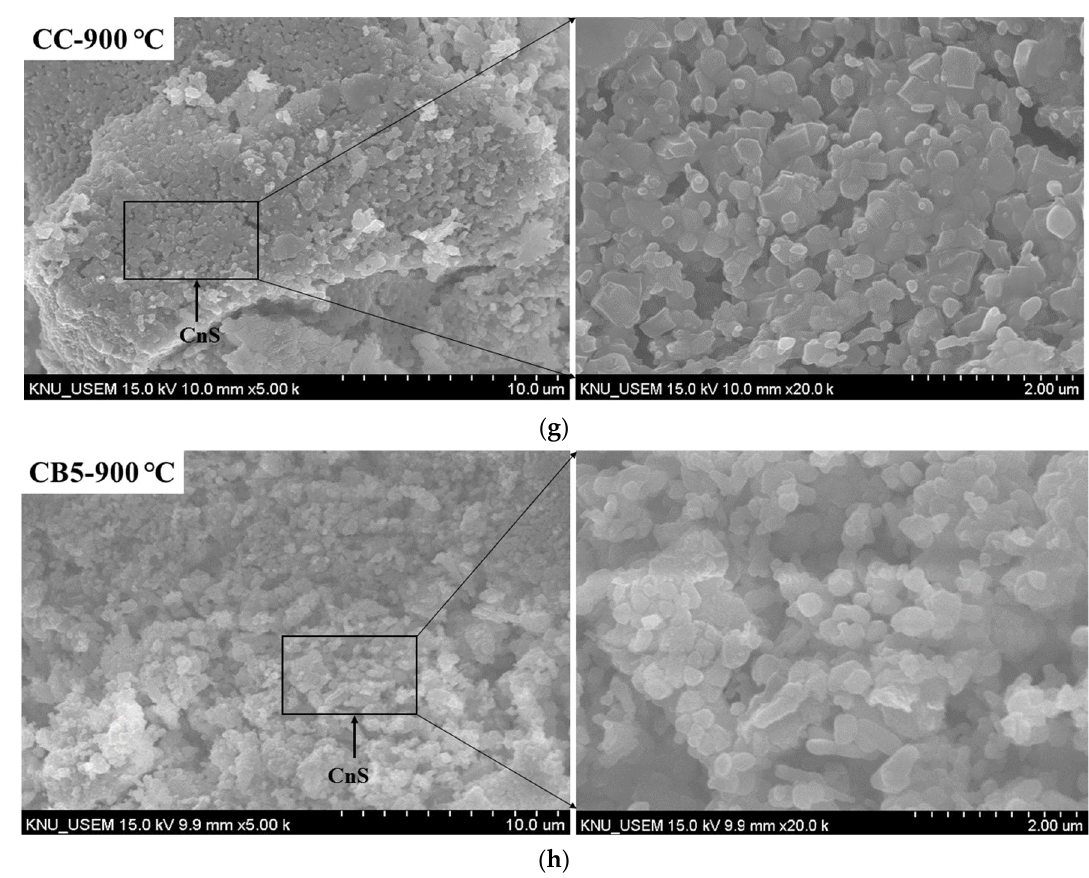
Figure 8. SEM images of CC and CB5 exposed to 20, 300, 550 and 900 °C. ( a ) SEM image of CC exposed to 20 °C. ( b ) SEM image of CB5 exposed to 20 °C. ( c ) SEM image of CC exposed to 300 °C. ( d ) SEM image of CB5 exposed to 300 °C. ( e ) SEM image of CC exposed to 550 °C. ( f ) SEM image of CB5 exposed to 550 °C. ( g ) SEM image of CC exposed to 900 °C. ( h ) SEM image of CB5 exposed to 900 °C.